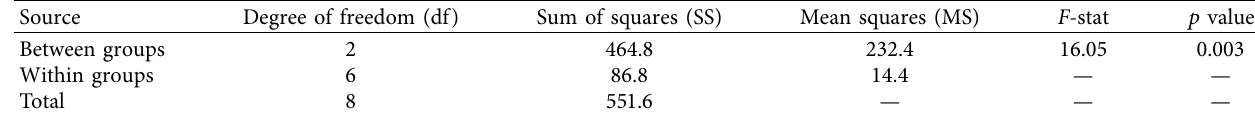
Table 7: ANOVA table of SOC stock between soil layers for Chir pine forest.